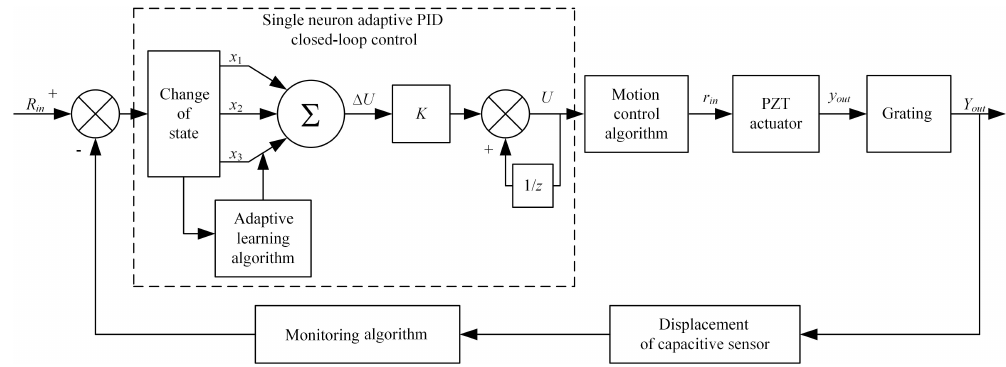
Figure 8. Schematic of single neuron adaptive PID control